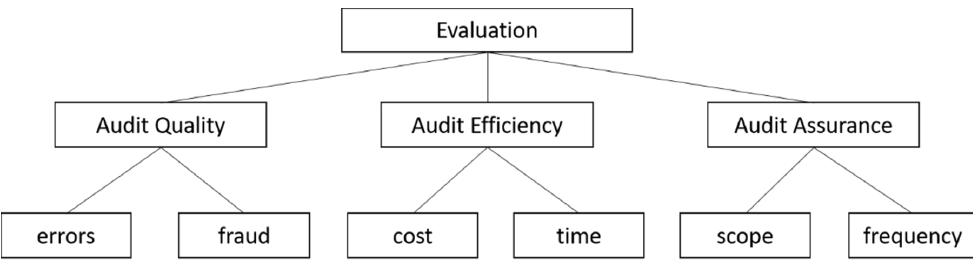
Figure 1. Literature review framework of procurement internal audit .